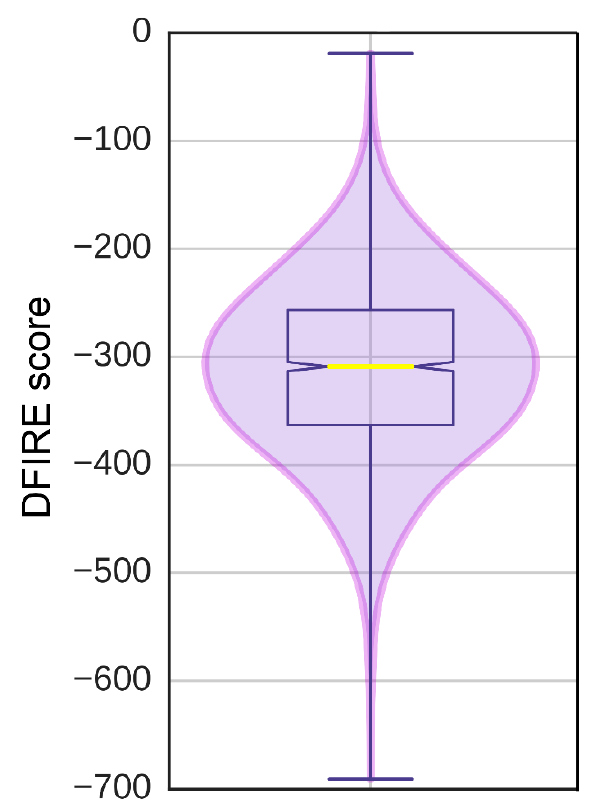
Figure 8. Distribution of DFIRE scores for protein-ATP complexes. Scores were calculated for the experimental structures of 1552 protein-ATP complexes.